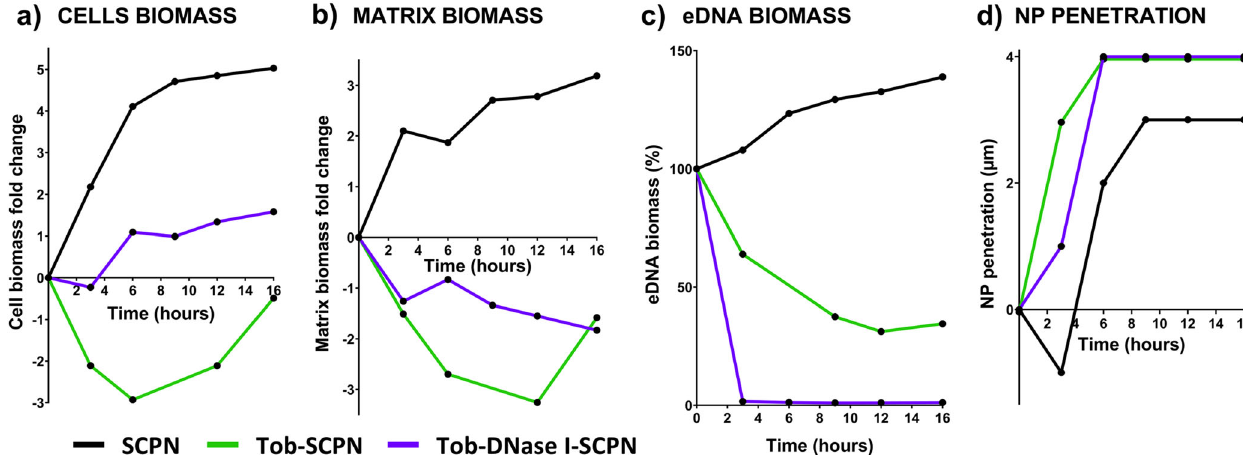
Fig. 4 Bio fi lm behavior components with time. Representative experiments on biomass variation over time in ( a ) cells, ( b ) matrix, and ( c ) extracellular DNA (eDNA) in a bio fi lm treated with SCPN (without tobramycin and DNase I) (black line), Tob-SCPN (green line), and Tob-DNase I-SCPN (purple line). The biomass variations in ( a , b ) are represented as fold changes, while the variations in ( c ) are described as percentages. d Positions of nanoparticle aggregates in the bio fi lm matrix. The results presented in this fi gure are representative of an experiment repeated at least twice with similar results.